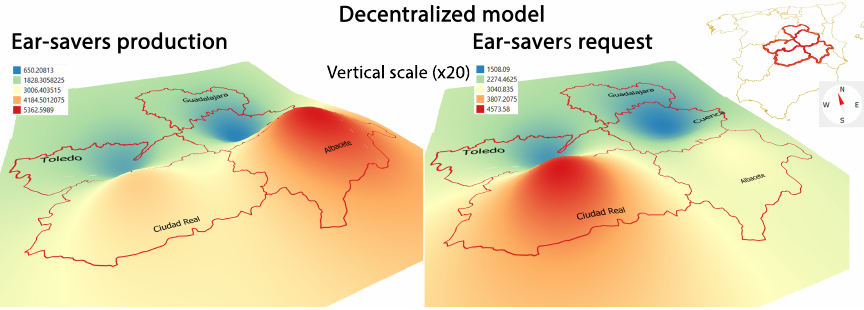
Figure 13. Flux map of the ear-savers production and delivery in the decentralized organizational